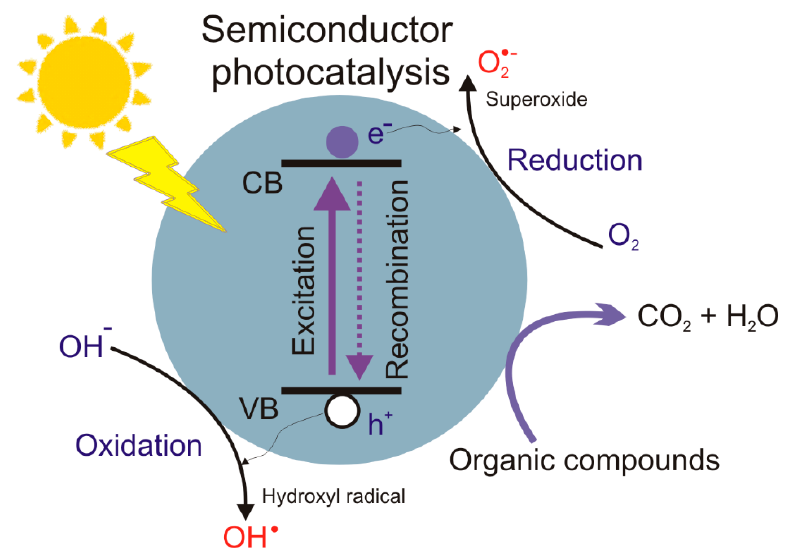
Figure 2. Mechanism of semiconductor photocatalysis. Adapted from [40] .